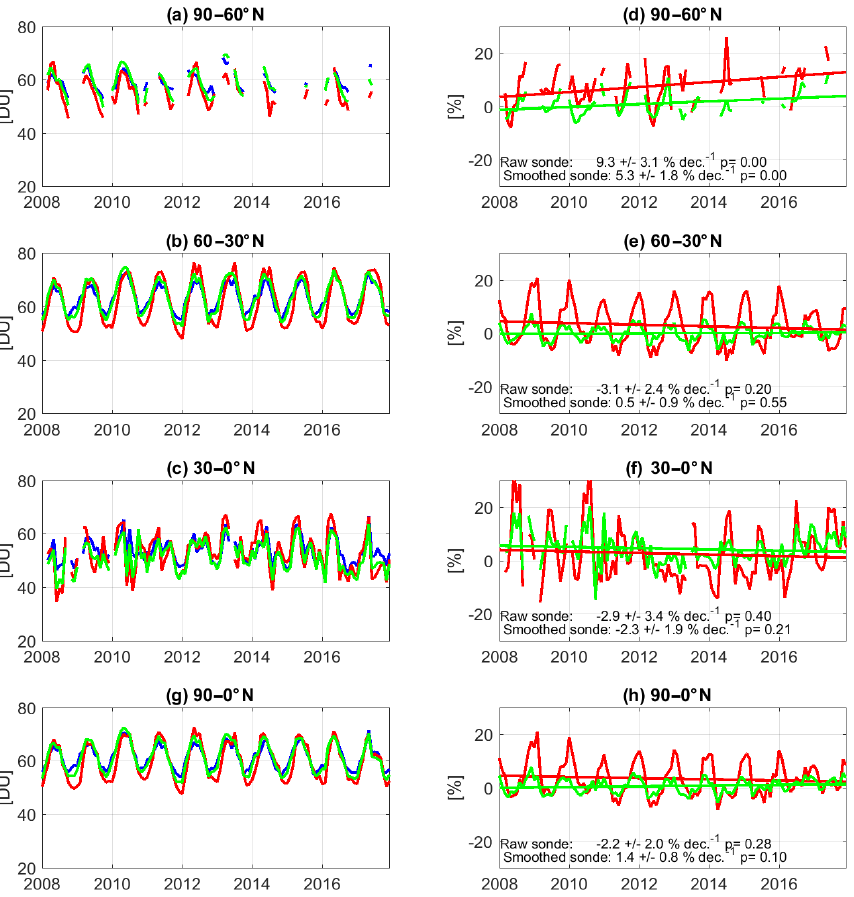
Figure 9. Time series of SOFRID-O3 v1.6 TOCs (DU) in the Northern Hemisphere for (a) 90–60 ◦ N, (b) 60–30 ◦ N, (c) 30–0 ◦ N and (d) 90– 0 ◦ N. Blue lines indicate IASI retrievals, red lines indicate raw sonde data, and green lines indicate smoothed sonde data. Differences (%) between IASI and sonde data for (e) 90–60 ◦ N, (f) 60–30 ◦ N, (g) 30–0 ◦ N and (h) 90–0 ◦ N. Red lines indicate differences with raw sonde data and green lines indicate differences with smoothed sonde